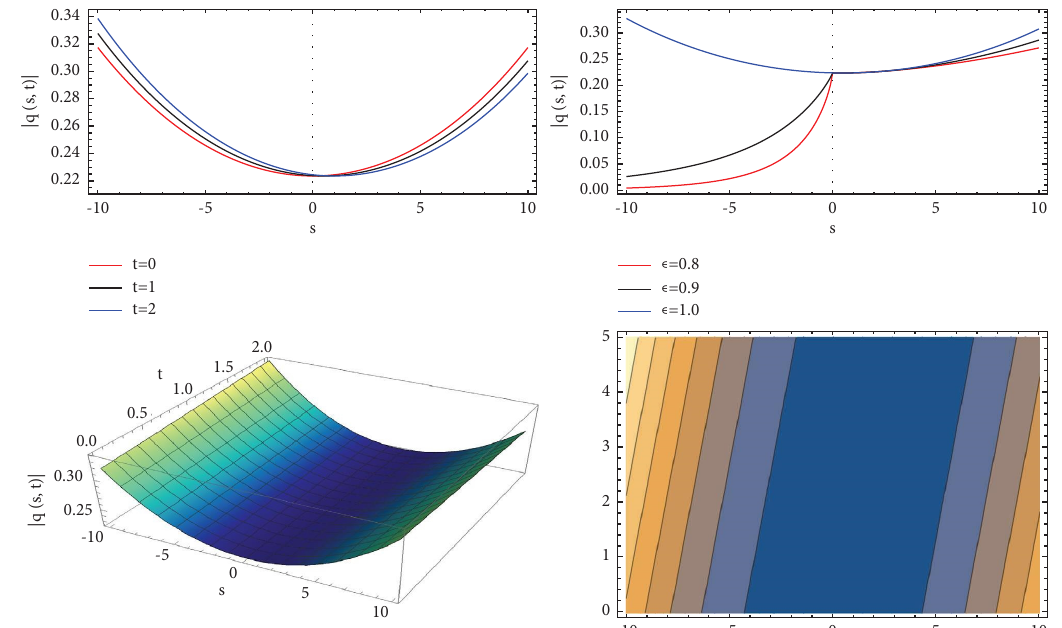
Figure 2: Structure of (41) for δ � 0 . 5 , λ � 0 . 1 , ϱ � 0 . 5 , μ � 1 , Ω � 0 . 1 , ϵ �